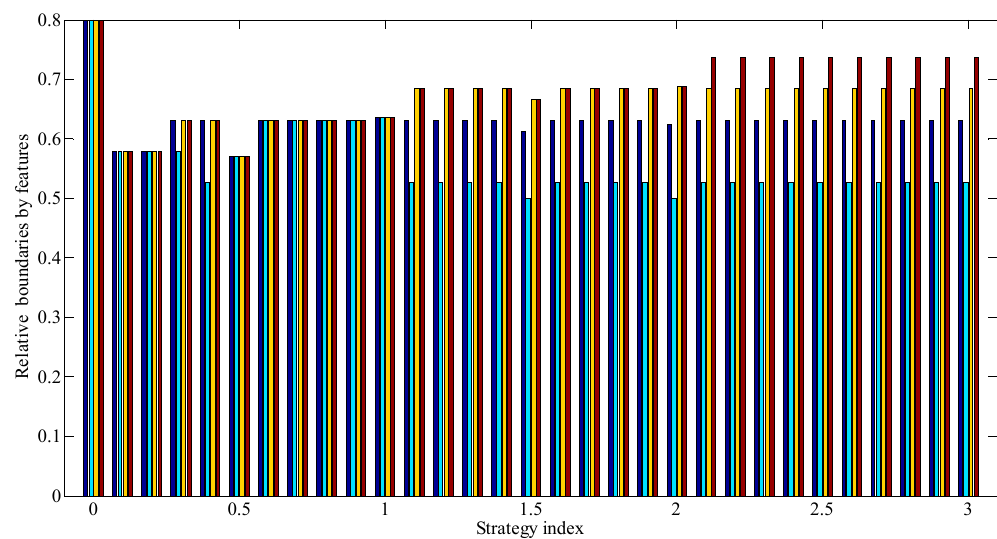
Figure 10. Diagram for the relative class boundaries by assessment features in rule groups.